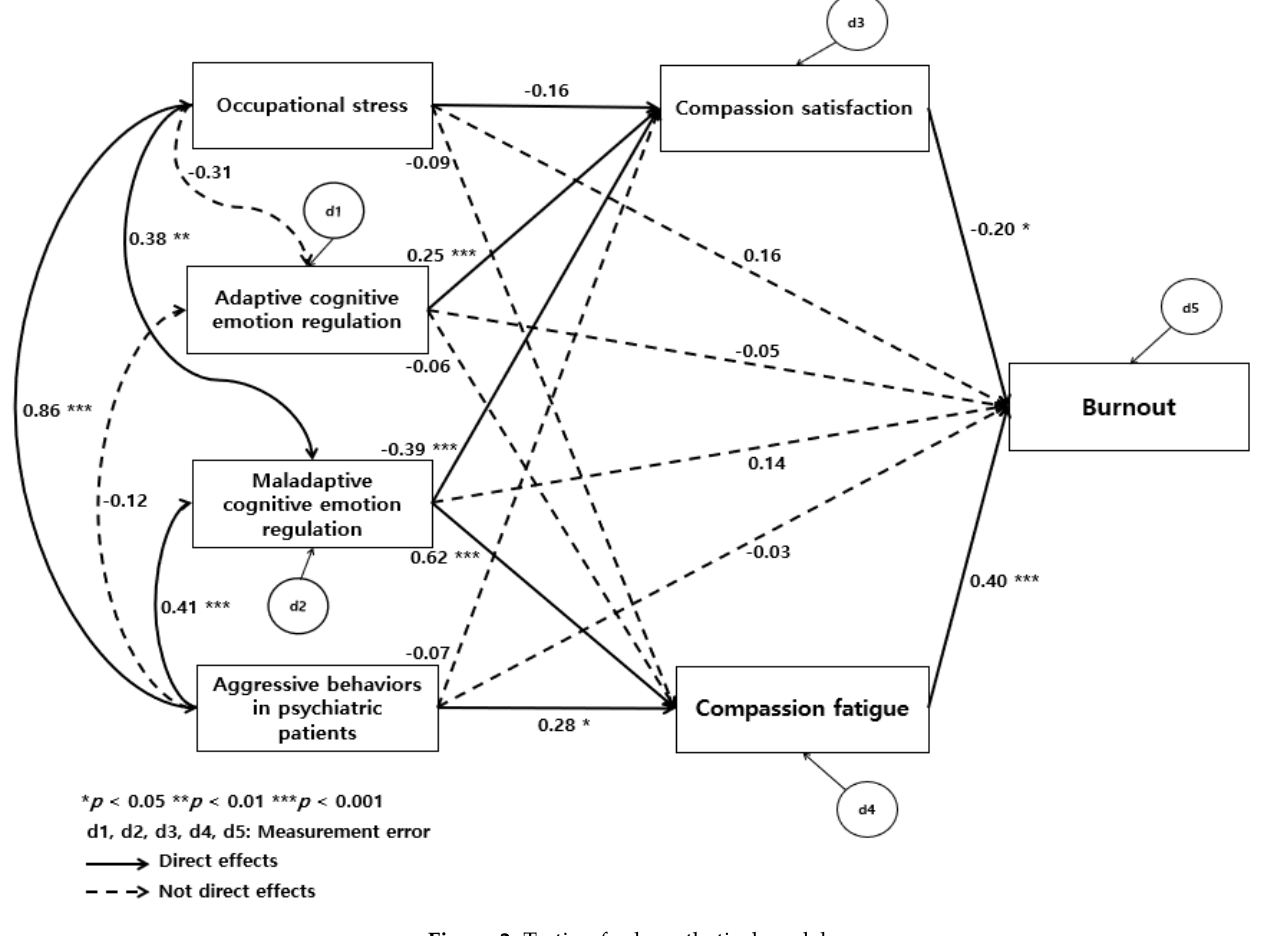
Figure 2. Testing for hypothetical model.